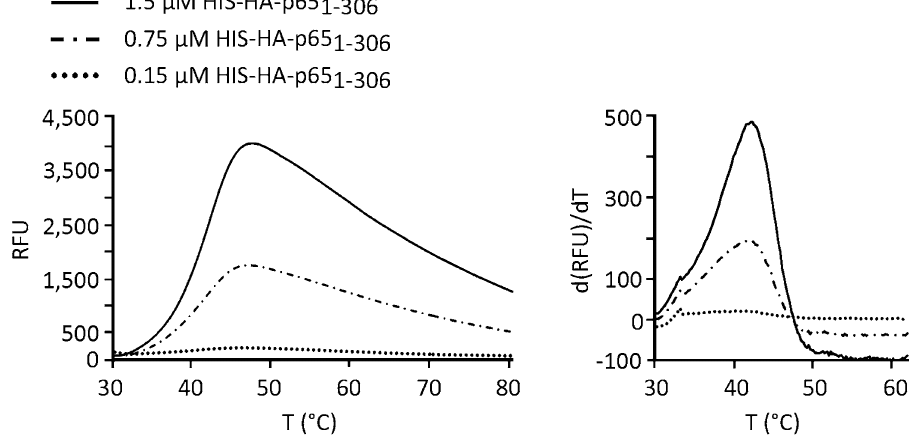
Figure 2. P65/RelA probe detection limit by using SYPRO Orange dye. The thermal denaturation was evaluated for a concentration series of p65 1-306 peptide using SYPRO Orange dye as in Fig. 1d. Representative unfolding (left) and positive derivative (d(RFU)/dT) (right) curves are shown. RFU relative fluorescence